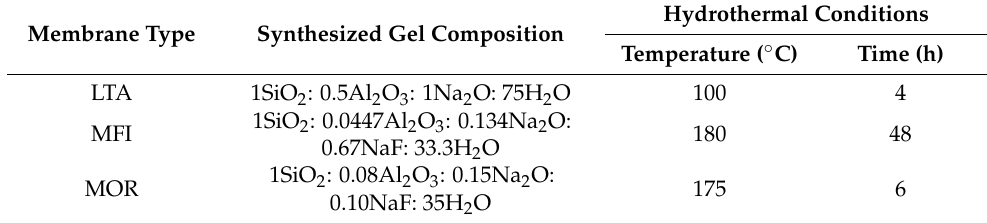
Table 1. Membrane preparation